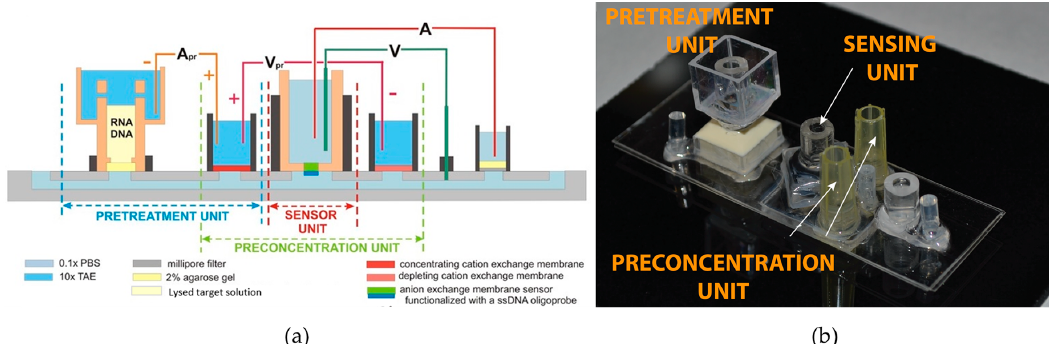
Figure 2. Integrated nucleic acid sensing platform. ( a ) Schematic of an integrated biosensing platform consisting of a pretreatment, preconcentration and sensing units; ( b ) Picture of the integrated biochip. Adapted with permission from [196]. PBS: phosphate-buffered saline; TAE: Tris-acetate-EDTA; ssDNA: single-strand DNA.